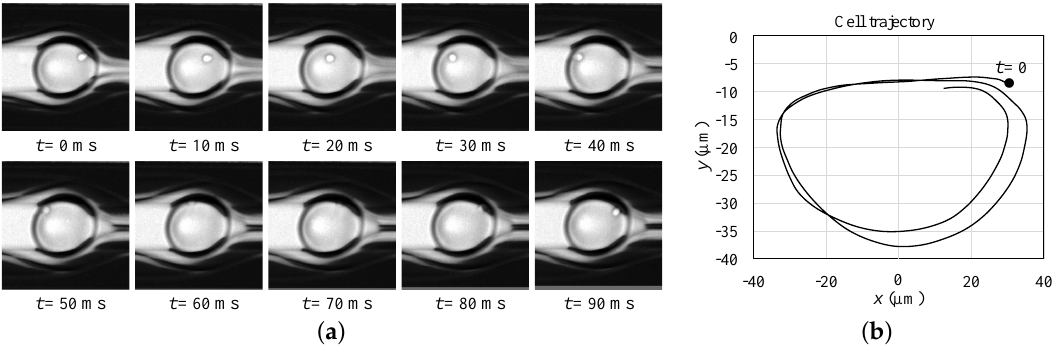
Figure 8. Experimental cell behavior: ( a ) time lapse still images showing MCF-10A cell position at different time frames, ( b ) cell spiral trajectory.